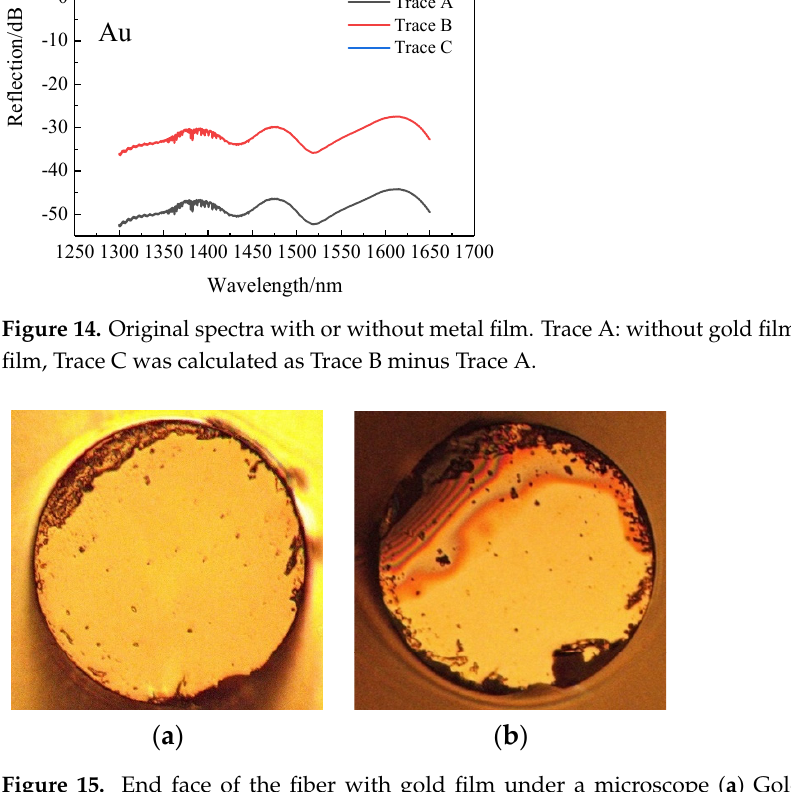
Figure 14. Original spectra with or without metal film. Trace A: without gold film, Trace B: with gold film, Trace C was calculated as Trace B minus Trace A.